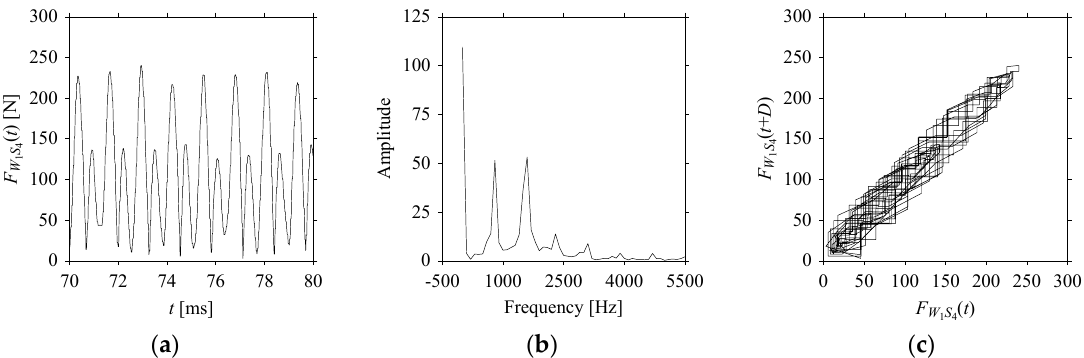
Figure 12. F W in the form of: ( a ) time series, ( b ) fast Fourier Transformation (FFT), and ( c ) delay map ( d = 1).